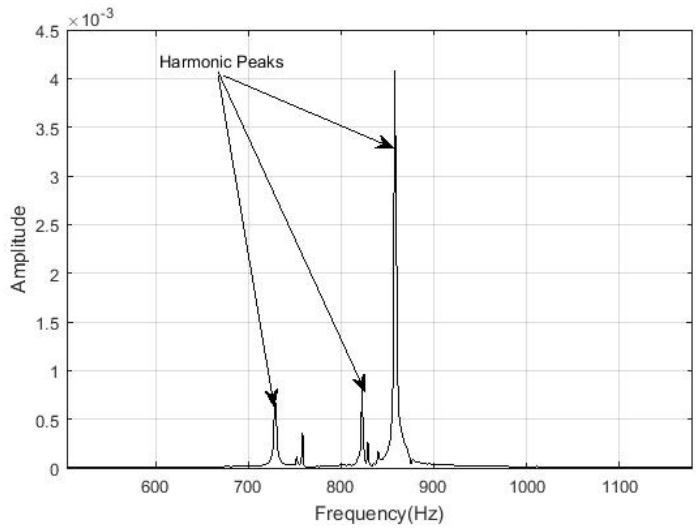
Figure 15. One broken bar signal spectrum before the noise reduction with zoom in the range of 500–1200 Hz.